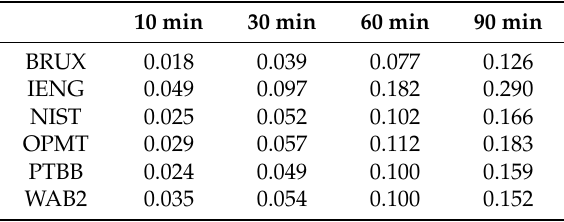
Table 3. The RMS values of the prediction error on six stations